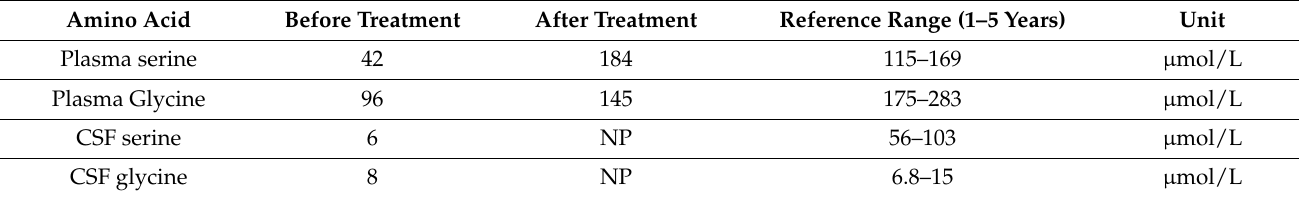
CSF: cerebrospinal fluid; NP: not